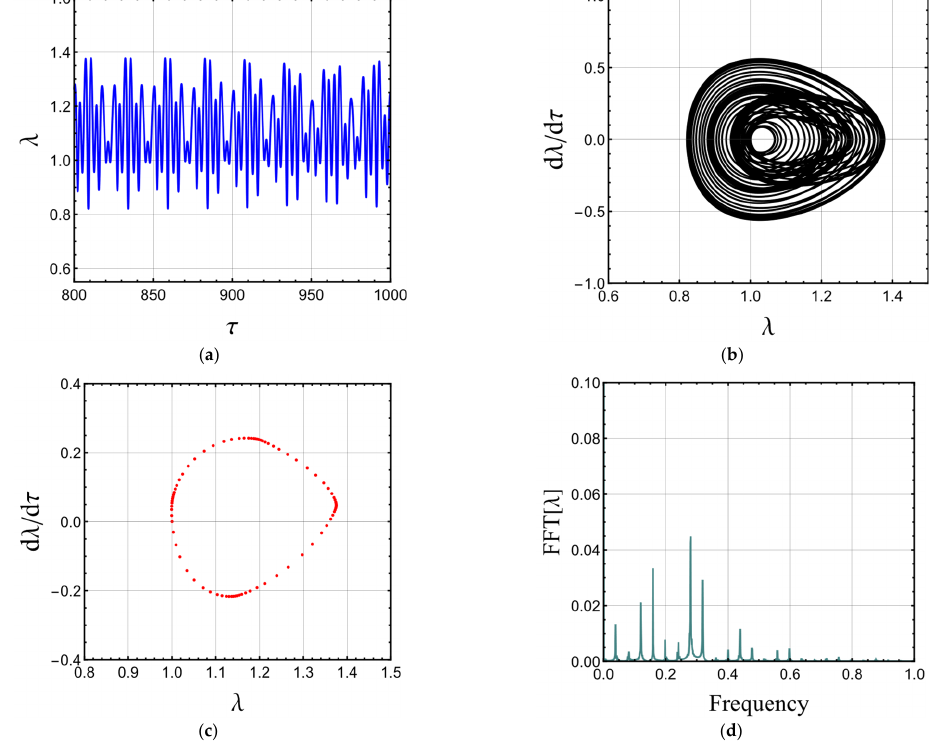
Figure 5. The dynamic response of the electro-magneto-active polymer to time-varying voltage 𝐻(cid:3365) (cid:2903) (cid:3404) 0 . ( a ) Time history, ( b ) phase plane diagram, ( c ) Poincaré map, and ( d ) FFT.